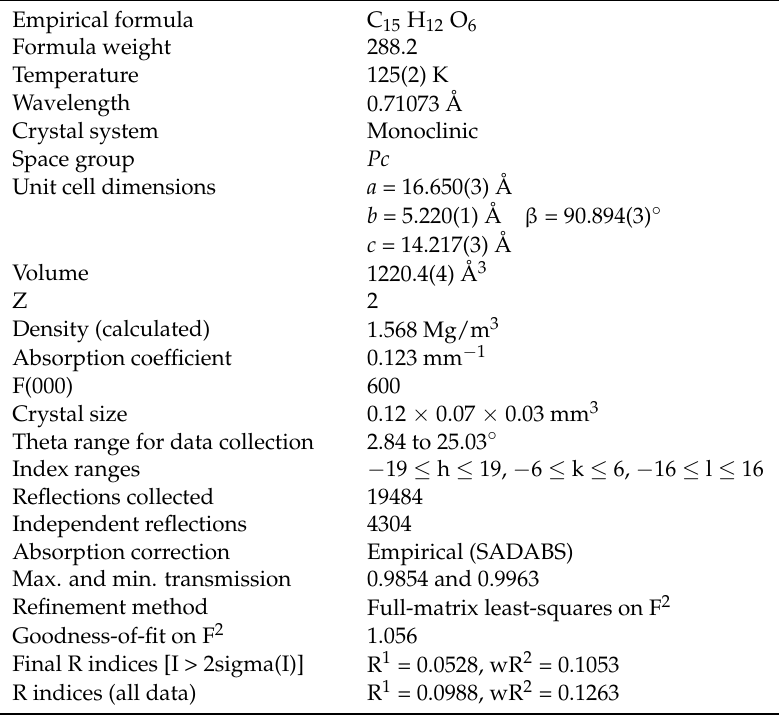
Table 1. Crystal Data and Structure Refinement for